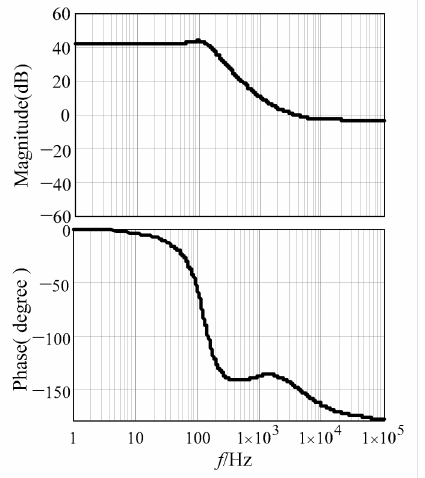
Figure 12. Bode diagrams of T ( s ) before correction.